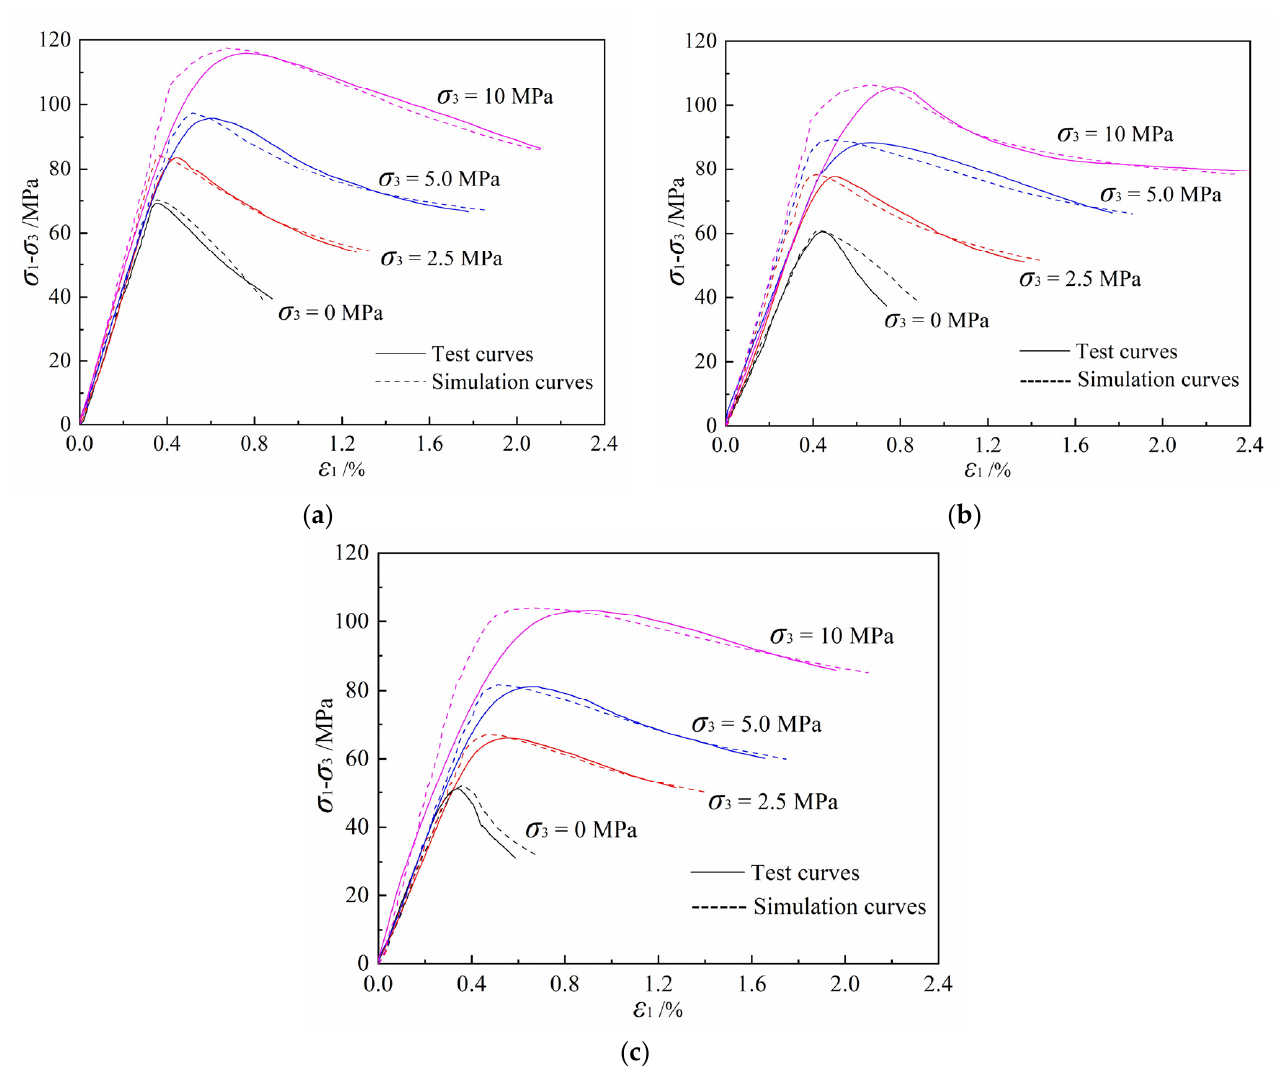
Figure 13. Comparison of simulation and test results of RAC under different curing conditions and confining pressures. (a) RAC20, (b) RAC6012, (c) RAC8009